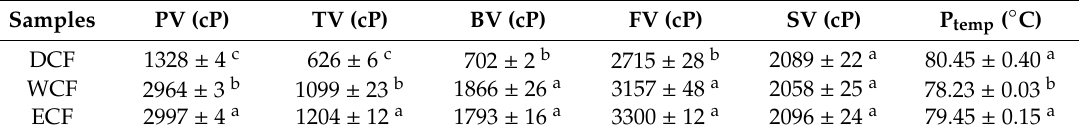
Table 2. Pasting properties of corn flour.